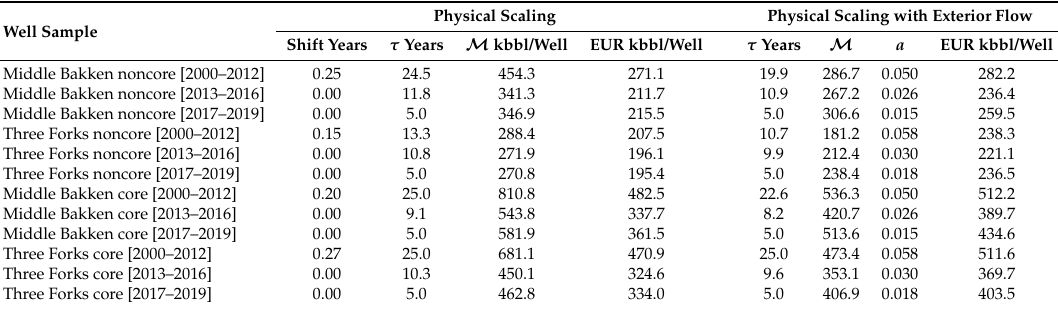
Table 2. Scaling parameters for an average well in the Bakken